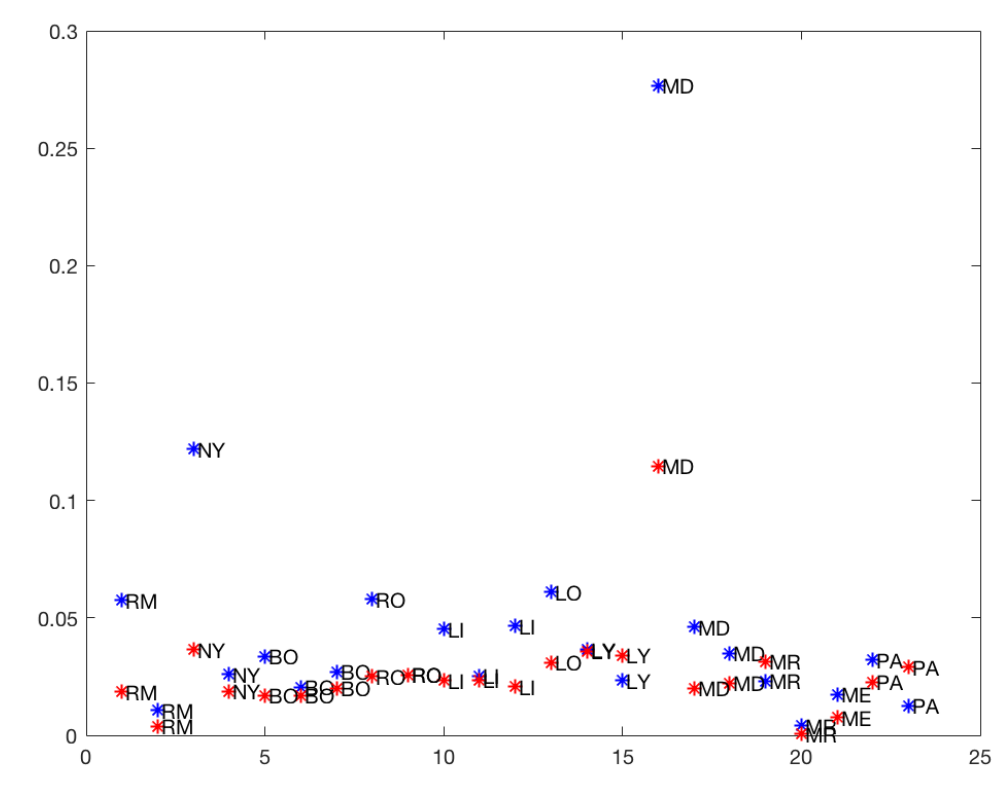
Figure 6. Upward slopes: blue: total , red : 50 %.